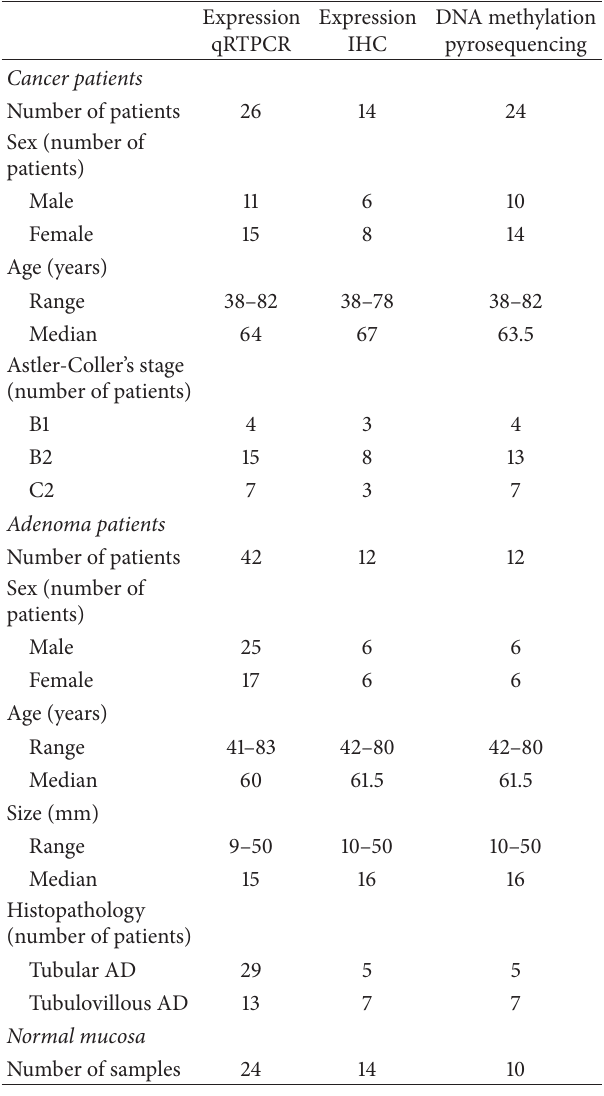
Table 1: Patients’